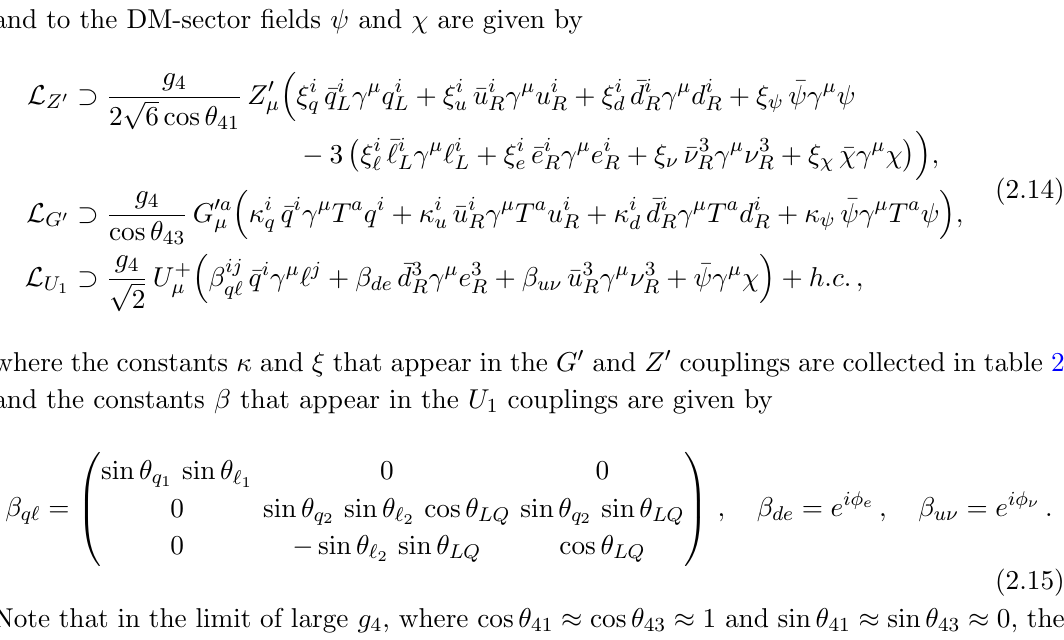
, Z 0 , and G 0 to the SM fermions 1